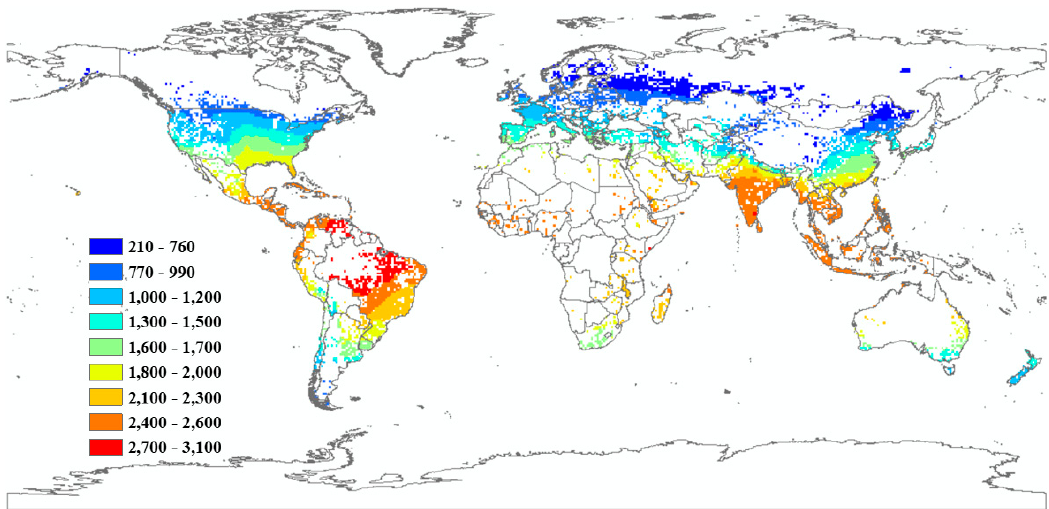
Figure 3. Net irrigation water requirement of CSIRO model in 2050 (RCP4.5). The same irrigated area than in 1960 is used the same in Figure 1. Table 2. CSIRO regional net irrigation water.